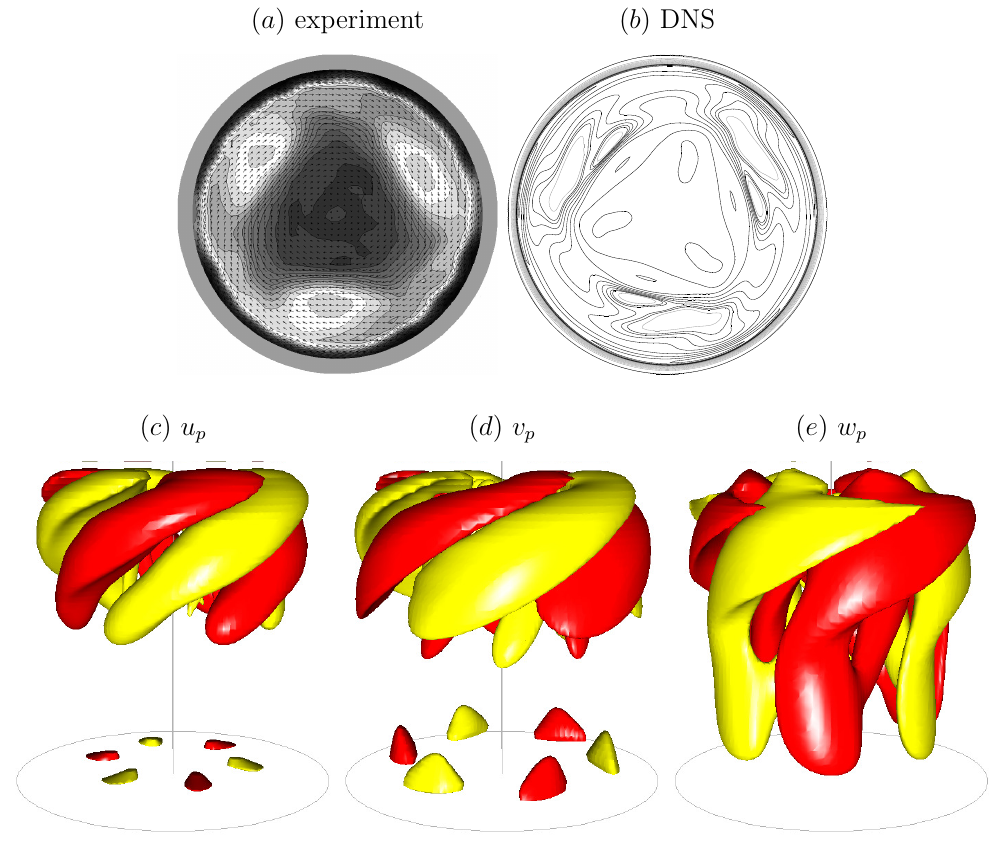
Figure 4. Axial vorticity at mid-depth from ( a ) experimental PIV measurements and ( b ) 3D Navier– Stokes simulations, and ( c – e ) isosurfaces of the computed perturbation velocity components. (Repro- duced with permission from [67], published by Cambridge University Press